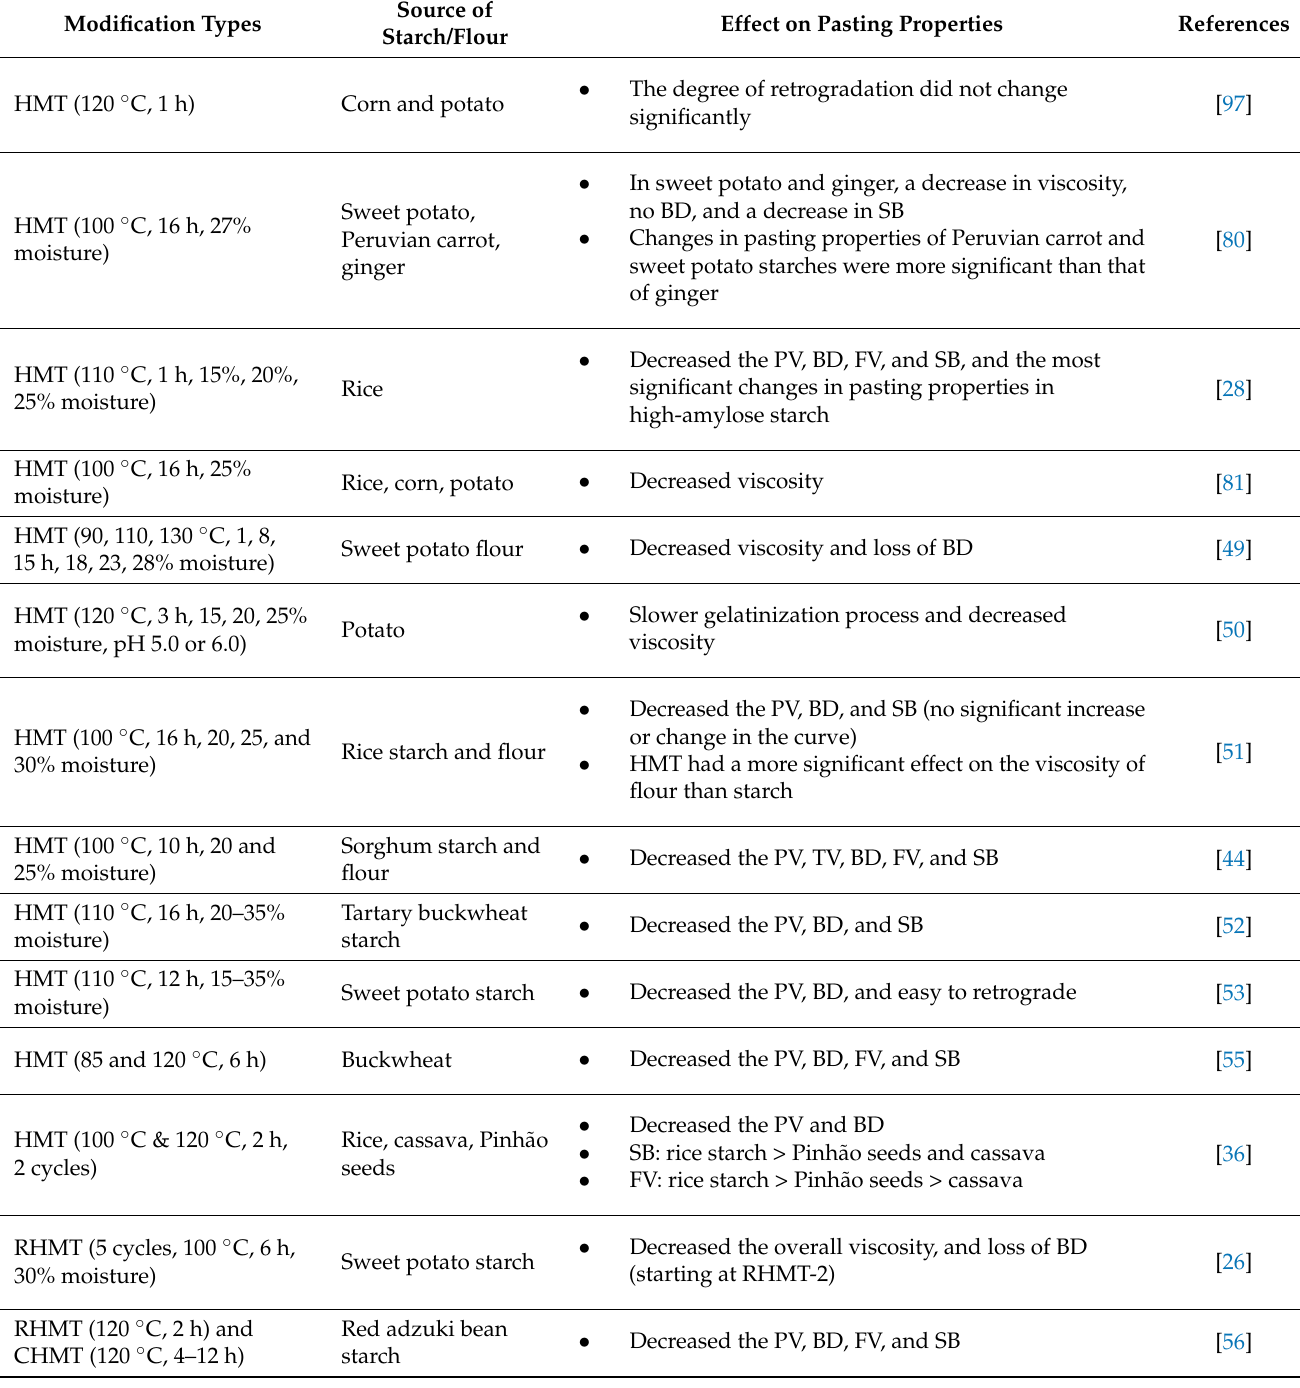
Table 3. Several studies related to the effect of hydrothermal modifications on the pasting properties of starch and